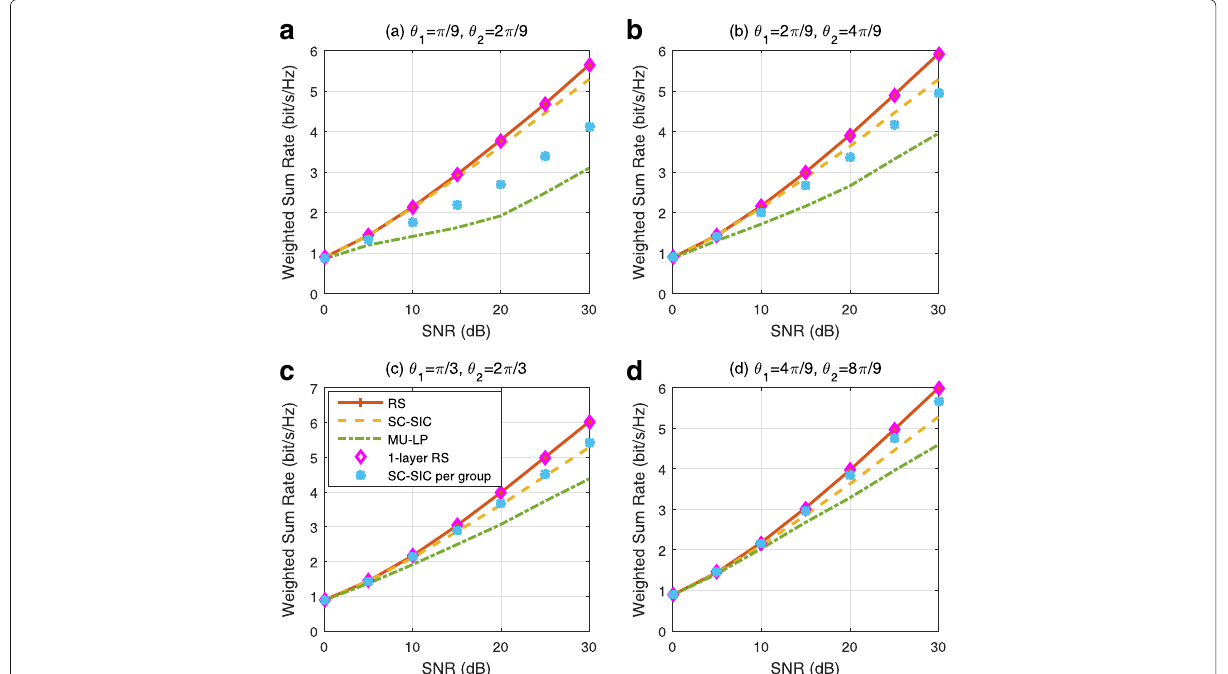
Fig. 52 Weighted sum rate versus SNR comparison of different strategies for overloaded three-user deployment with imperfect CSIT, γ 1 = γ 2 = 1, u 1 = 0.2, u 2 = 0.3, u 3 = 0.5, N t = 2, r th = [0.02,0.08,0.19,0.3,0.4,0.4,0.4] bit/s/Hz. a θ 1 = π/ 9, θ 2 = 2 π/ 9. b θ 1 = 2 π/ 9, θ 2 = 4 π/ 9. c θ 1 = π/ 3, θ 2 = 2 π/ 3.